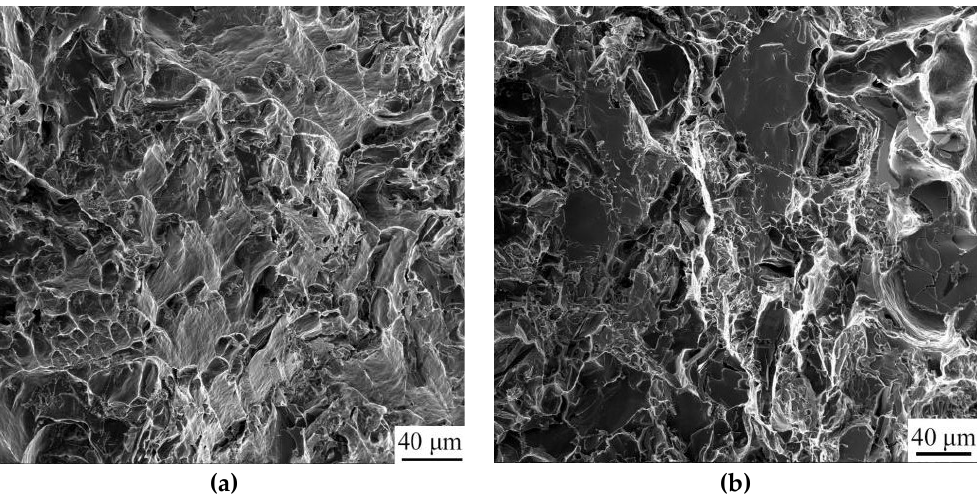
Figure 10. The creep fracture morphology of Al-Si-Cu-Ni-Mg alloy at ( a ) 20 MPa/250 °C and ( b ) 28 MPa/250